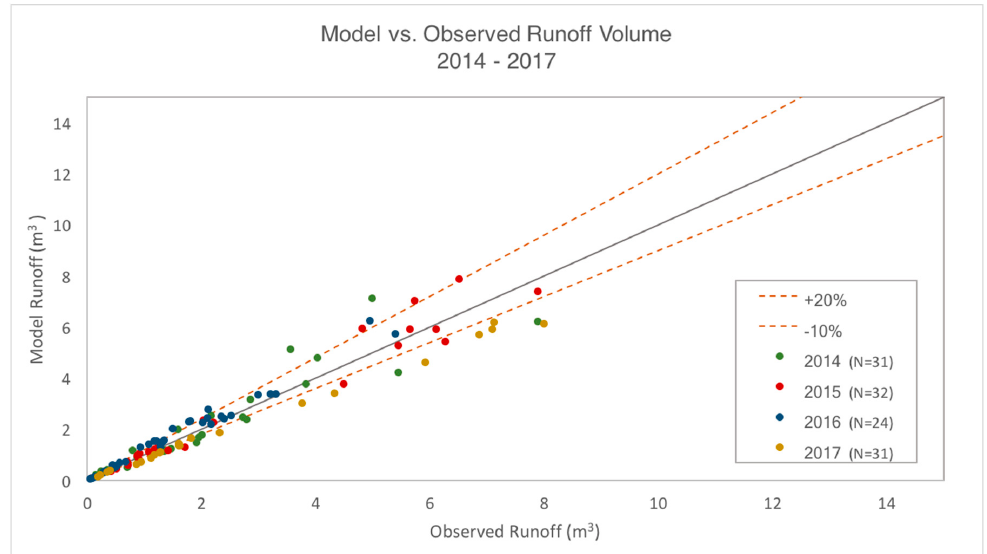
Figure 7. Model vs. observed total runo ff validation envelope (+20% to − 10%).